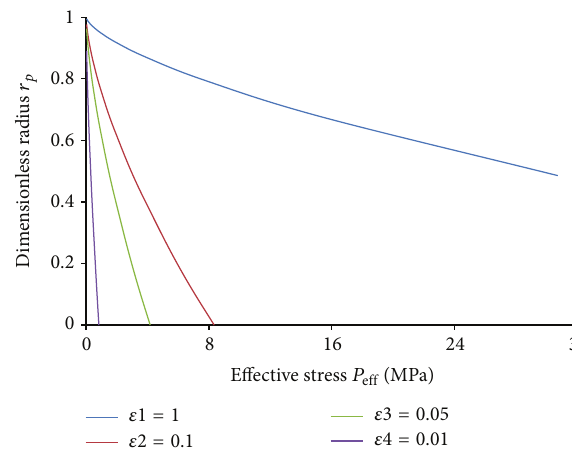
Figure 6: Effect of aspect ratio on triangular pores.